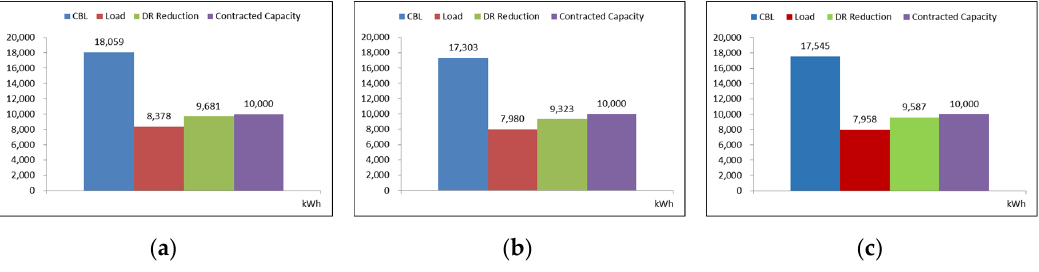
Figure 9. N company demand response result (data of 20 July 2017, 14:00~17:00). Table 7. Result of demand response from customer.